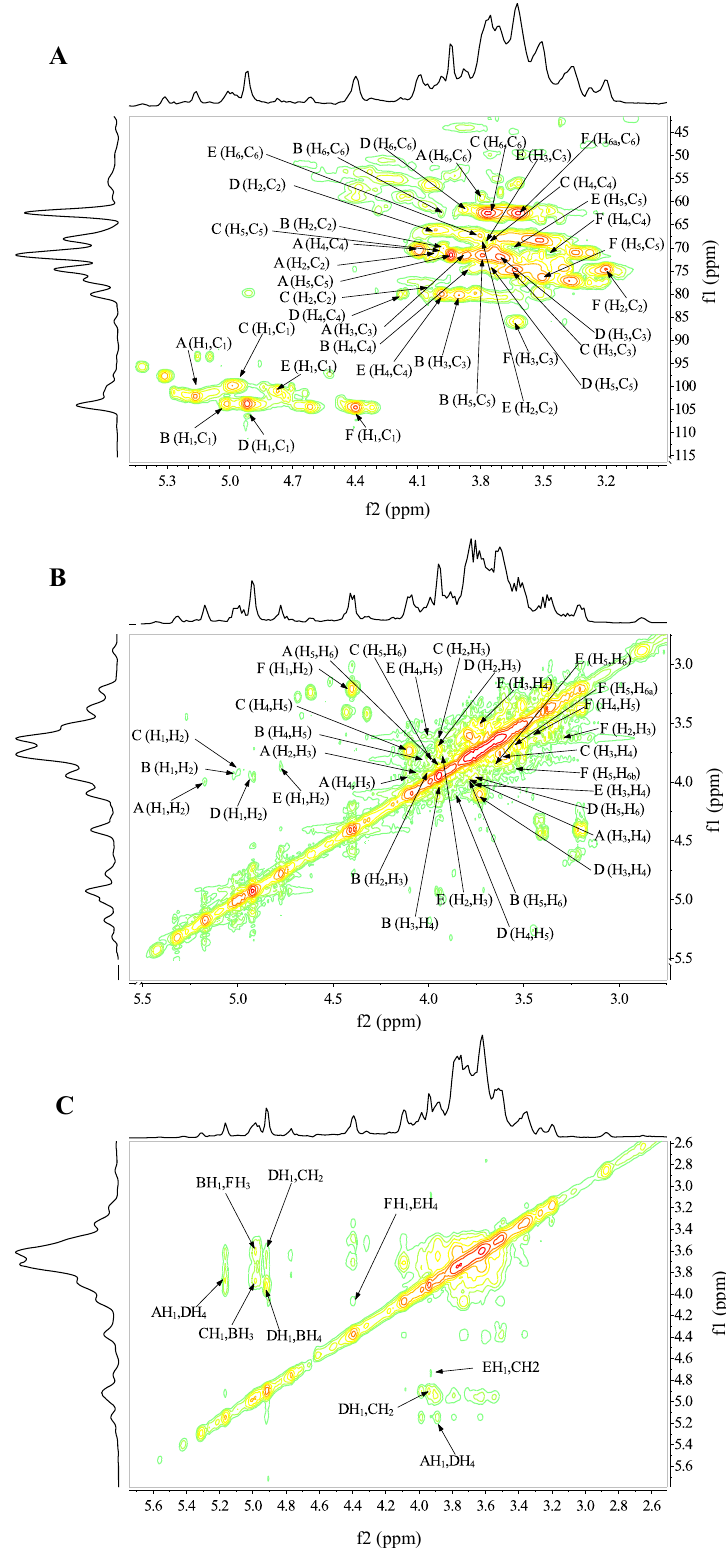
Figure 3. NMR spectrum analysis of S1. ( A ) 1 H- 13 C HSQC spectrum, ( B ) 1 H- 1 H COSY spectrum, ( C ) NOESY spectrum.